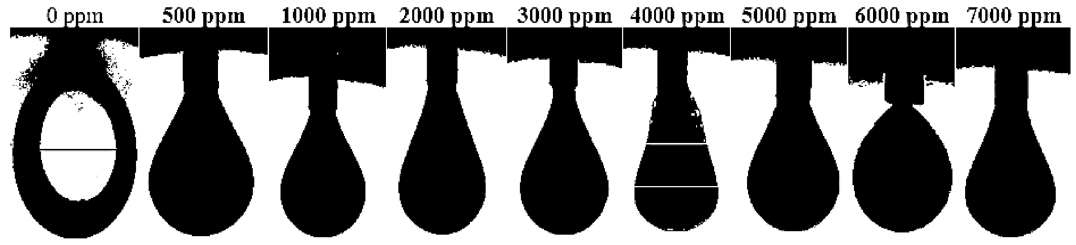
Fig. 13 Shape profiles of crude oil droplets against surfactant solutions